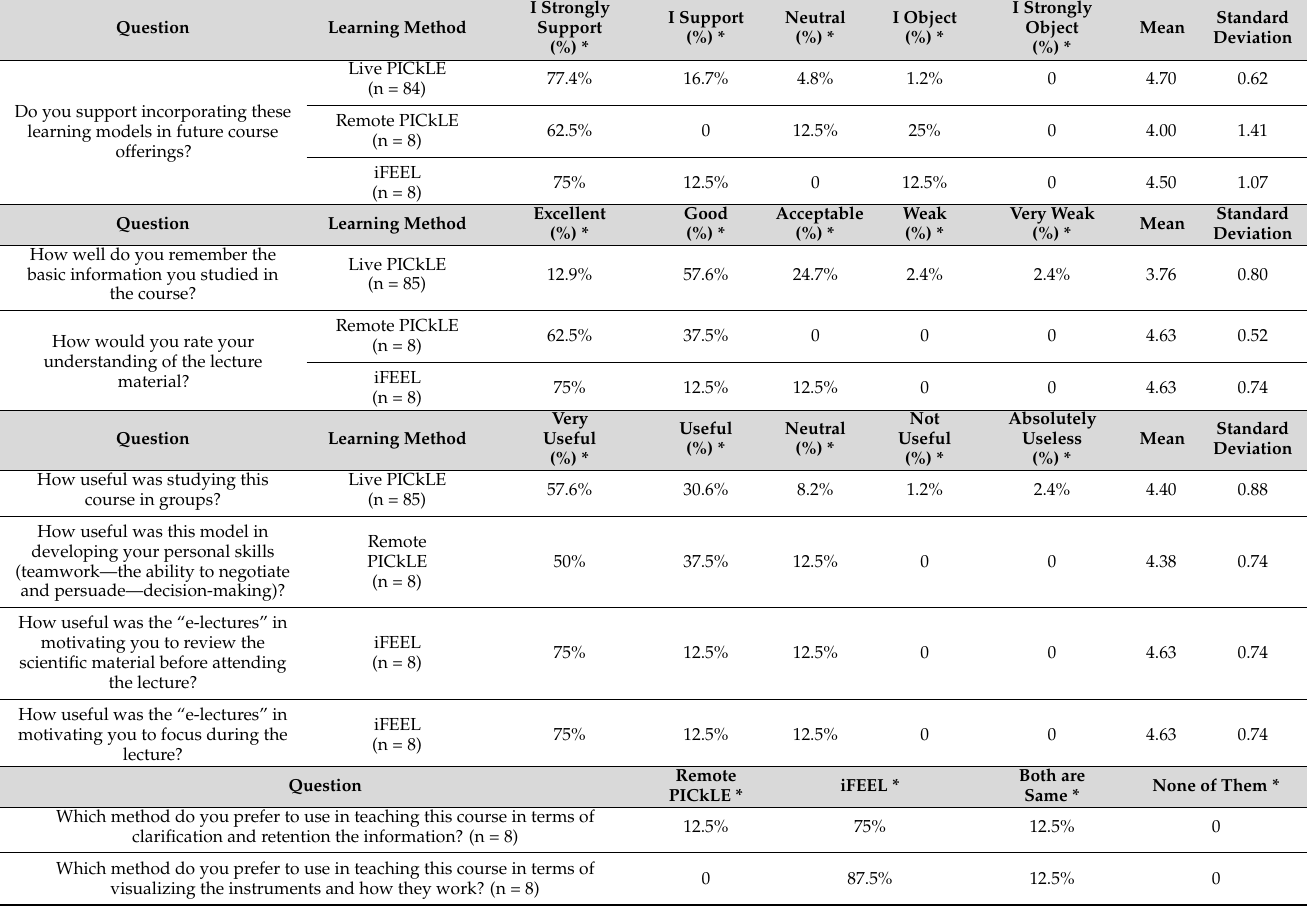
Table 3. Students’ perceptions about the live PICkLE, remote PICkLE, and iFEEL